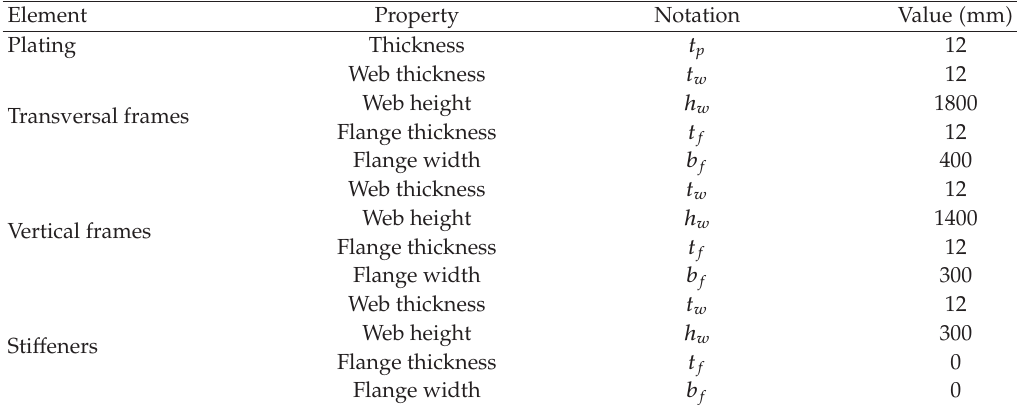
Table 6: Geometrical date defining gate